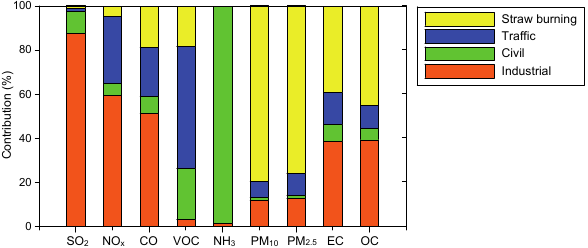
Fig. 2. Percent contributions from different sectors to the total emis- sions in the larger Huabei region for the year 2003.